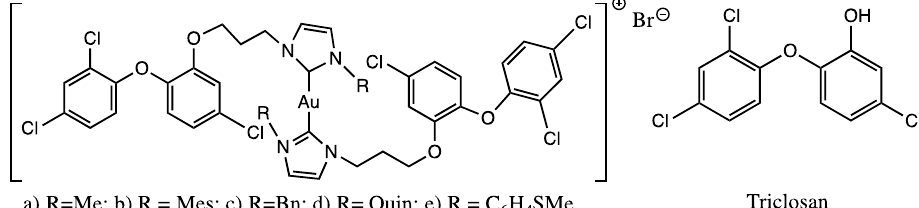
Figure 5. Gold(I)-NHC-TC hybrid molecule and triclosan compound screening against Leishmania sp. and Plasmodium sp